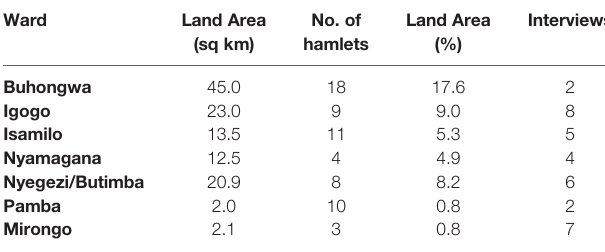
TABLE 1 | Mwanza City ward locations with corresponding information on the land area and the number of hamlets in each ward (Mwanza City Council, 2017; Mwanza City Council, 2008), and the number of interviews conducted in each